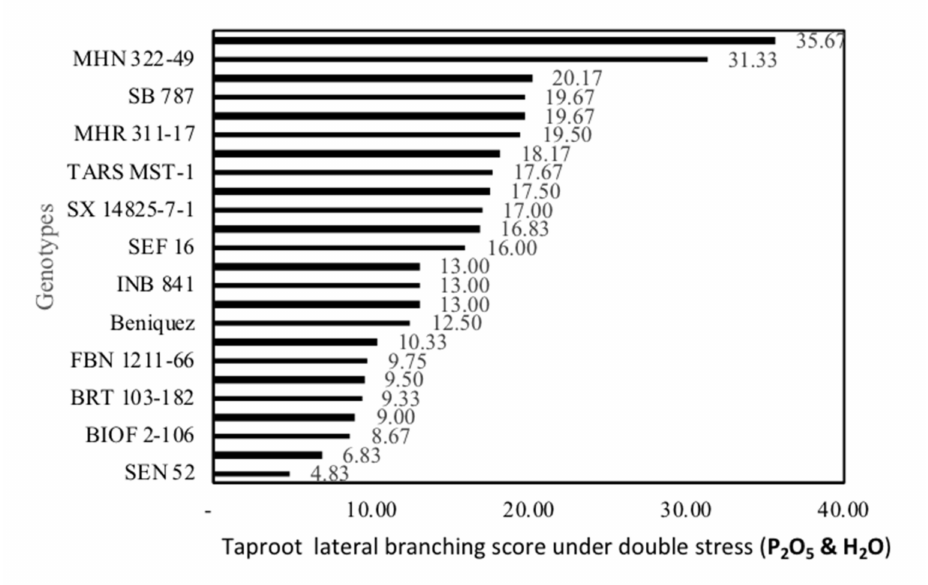
Figure 2. Taproot lateral branching score of 24 genotypes grown under low P and drought stress at Ch ó kw è Research Station.